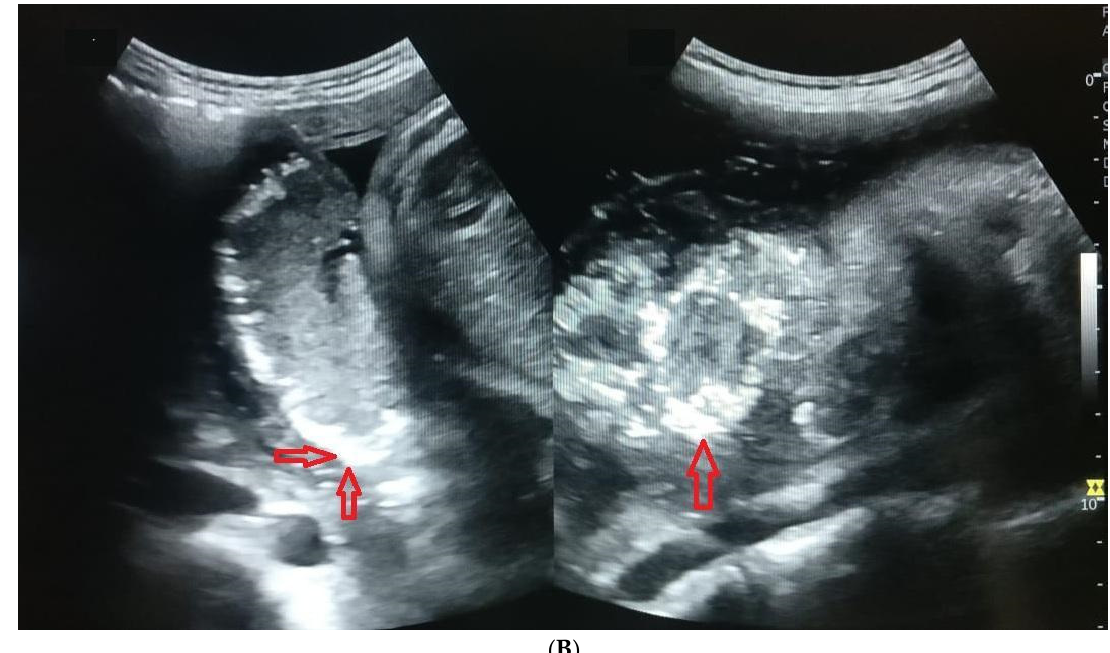
Figure 2. ( A ) Image showing placental calcification and lobulation (grade 3 placenta) in a case of 26-year-old primigravida at a gestational age of 33 weeks and 6 days. Red arrows show the placental calcification and blue arrows show lobulations. ( B ) Image showing grade 3 placental calcification in a 31-year-old primigravida at a gestational age of 35 weeks and 1 day. Red arrows show the placental calcification.